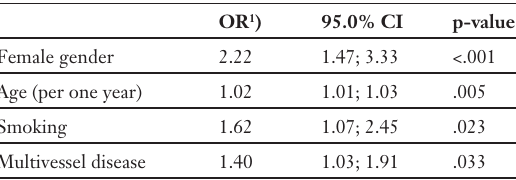
Independent predictors of functional impairment (NYHA >1) at late